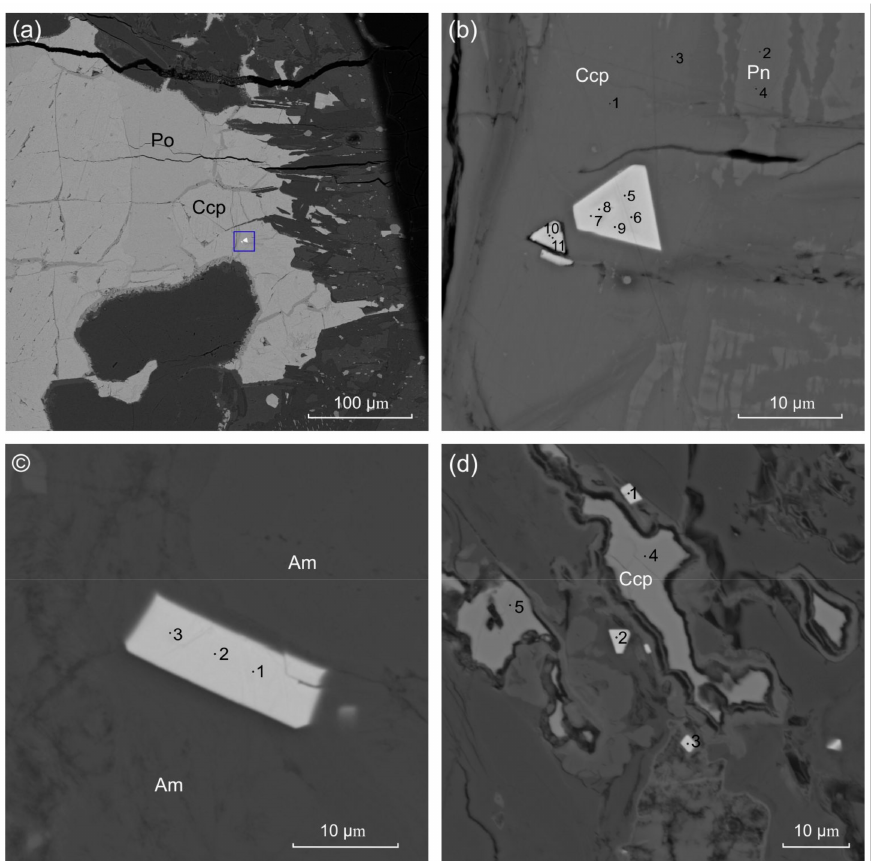
Figure 3. Back-scattered electron image of Re sulfides: ( a ) Position of rhenium sulfide in pyrrhotite– chalcopyrite–pentlandite aggregate (sample 09-6); ( b ) Enlarged fragment of Figure 3a (blue square); ( c,d ) sample 06-02. Am: amphibole, Ccp: chalcopyrite, Pn: pentlandite, Po: pyrrhotite. The points correspond to the analyses in Tables 1 and